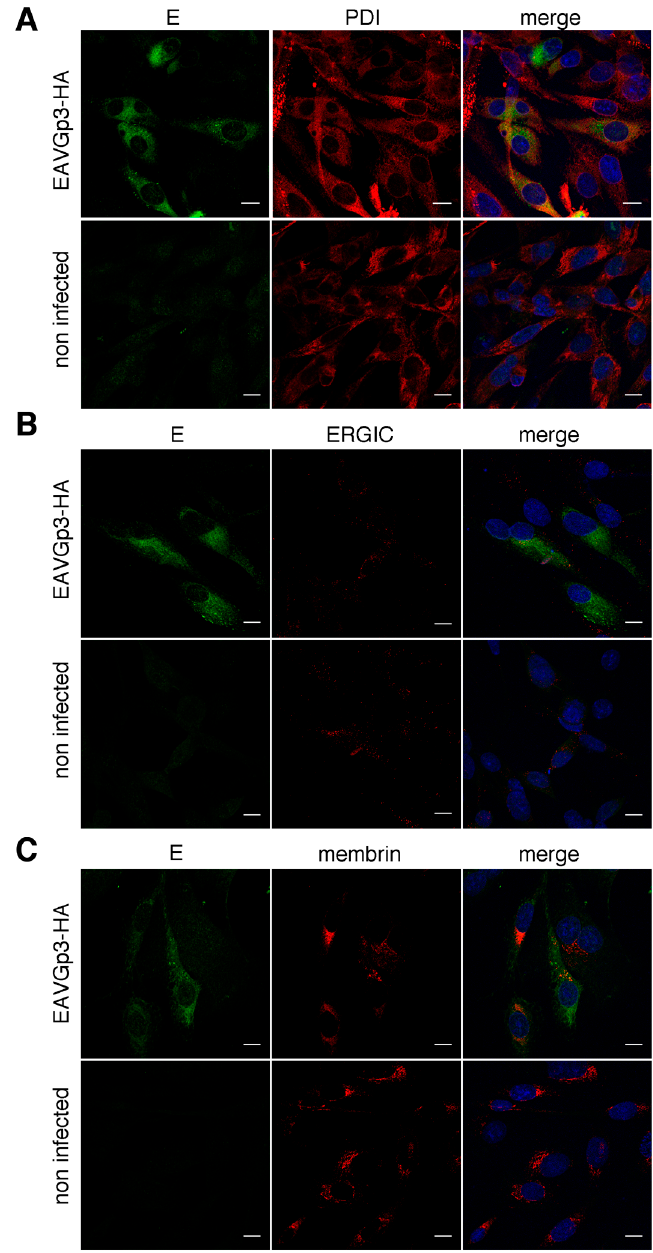
Figure 6. Co-localization of E with markers of the secretory pathway. The BHK-21 cells were infected with EAVGp3-HA at an MOI of 1 or left uninfected. The cells (18 h p.i.) were then subjected to immunofluorescence. E partially co-localizes with PDI, marker for ER ( A ). Confocal analysis of the immunofluorescence samples stained with rabbit anti-E antibodies and mouse anti-PDI antibodies and secondary antibodies Alexa Fluor 568 anti-mouse and Alexa Fluor 488 anti-rabbit antibodies. E is shown in green, PDI is shown in red. E minimally co-localizes with ERGIC ( B ). Confocal analysis of the immunofluorescence samples stained with rabbit anti-E antibodies and mouse anti-ERGIC53 antibody and secondary antibodies Alexa Fluor 568 anti-mouse and Alexa Fluor 488 anti-rabbit antibodies, respectively. E is shown in green, ERGIC is shown in red. E partially co-localizes with membrin, marker for cis-Golgi ( C ). Confocal analysis of the immunofluorescence samples stained with rabbit anti-E antibodies and mouse anti-membrin antibodies and secondary antibodies Alexa Fluor 568 anti-mouse and Alexa Fluor 488 anti-rabbit antibodies. E is shown in green, membrin is shown in red. The cell nuclei were stained with DAPI. Scale bar = 10 µ